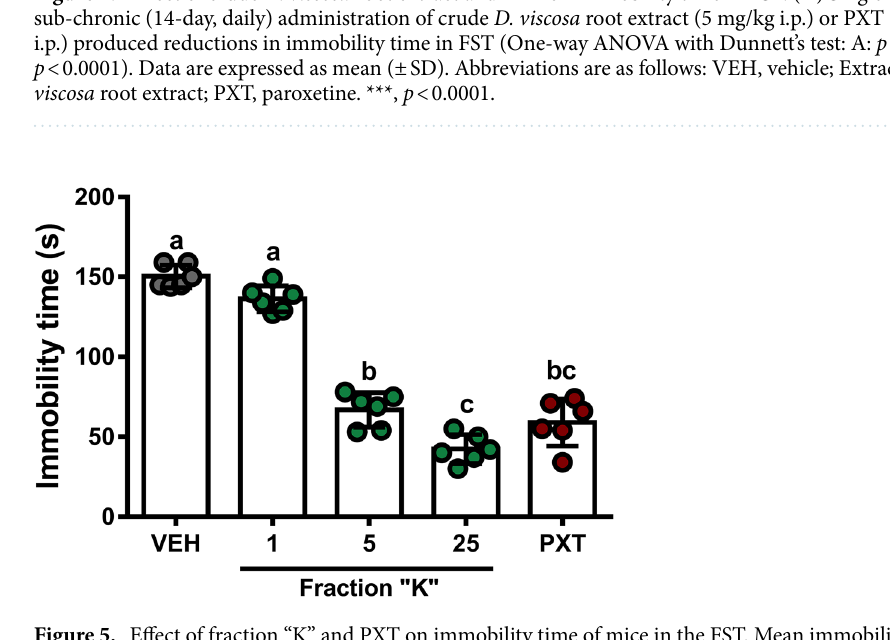
Figure 5. Effect of fraction “K” and PXT on immobility time of mice in the FST. Mean immobility time (± SD) in FST following a single i.p. dose of fraction “K” (0–25 mg/kg) or PXT (10 mg/kg) differed from both 1.0 mg/ kg fraction “K” treatment and control (One-way ANOVA, p < 0.0001). Different letters indicate significant differences (Tukey’s HSD, p < 0.0001 all treatments except 25 mg/kg fraction “K” vs. PXT [ p =